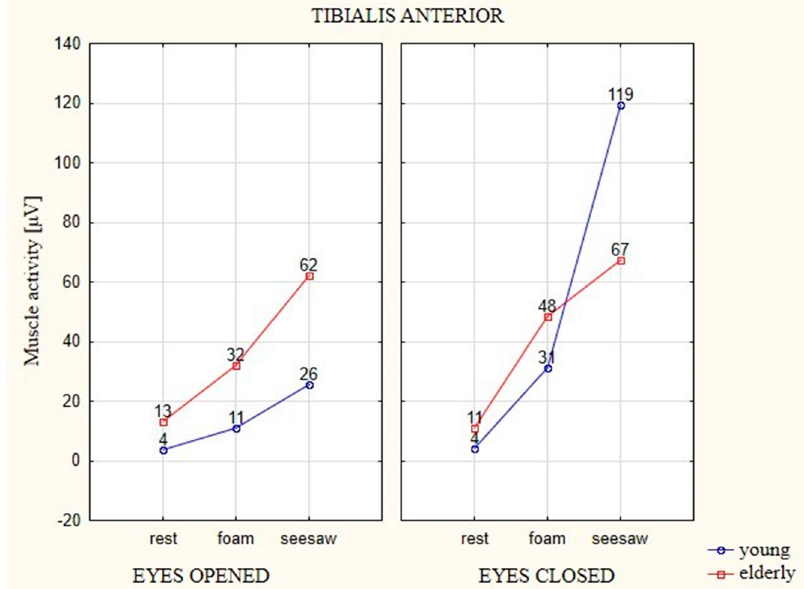
Figure 5. The average EMG values of the TA muscle in elderly and young participants on different types of surfaces and with EO (eyes 1) and EC (eyes 2).